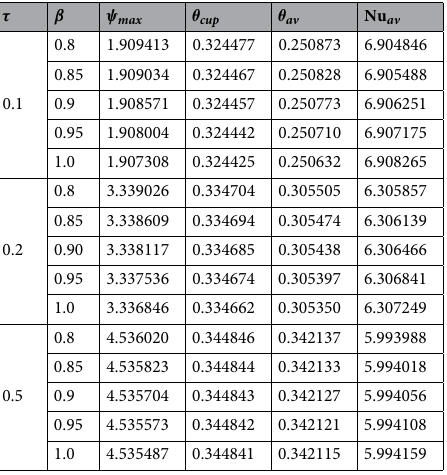
Table 5. Impacts of the fraction derivatives order β and dimensionless time parameter τ on the maximum values of the stream function, cup-mixing temperature, bulk-averaged temperature and average Nusselt number at Ra = 10 5 , Da = 10 − 3 , b = 0.6, d = 0.5, Ma = 1000, φ = 2%, Rd = 1, � = 10 − 4 , N = 0.91, γ = 90